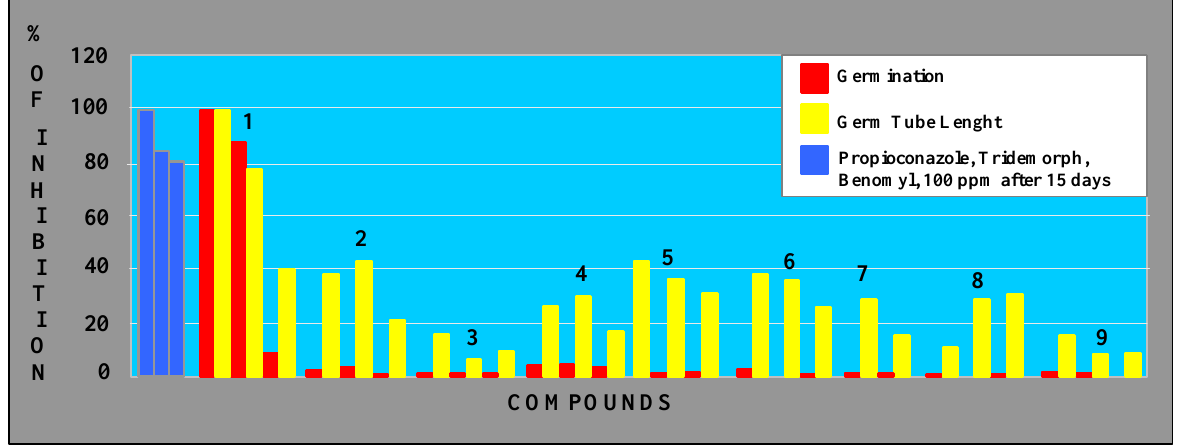
Figure 3. Antifungal activity on M. fijiensis